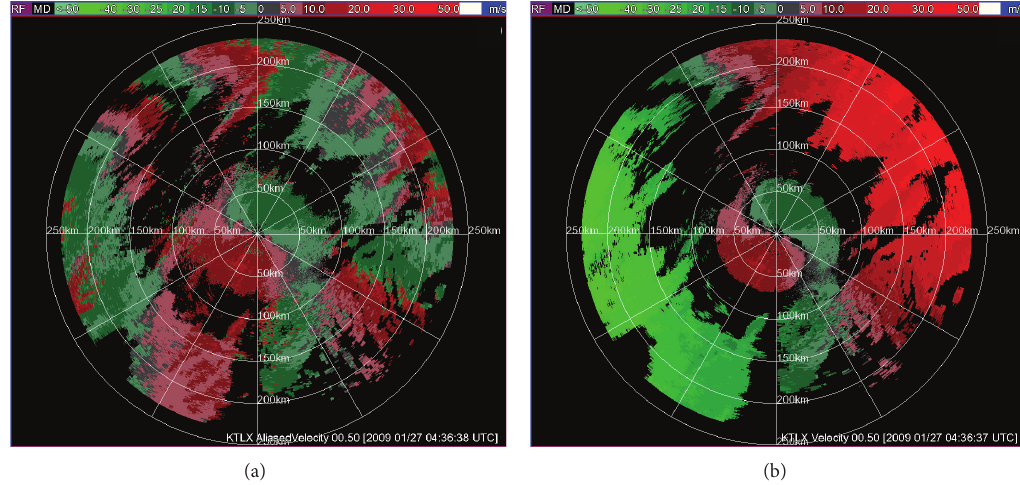
Figure 4: (a) Raw radial-velocity image scanned by the KTLX radar using VCP31 mode with Nyquist velocity = 11.51ms −1 at 0.5 ∘ tilt for the Oklahoma ice storm at 043637 UTC on January 27, 2009. (b) Dealiased radial-velocity image by the adaptively upgraded dealiasing scheme. The color bar on the top of each panel shows the velocity scales.